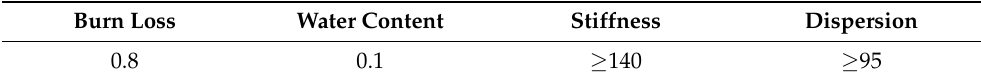
Table 6. Technical indicators of alkali-free glass